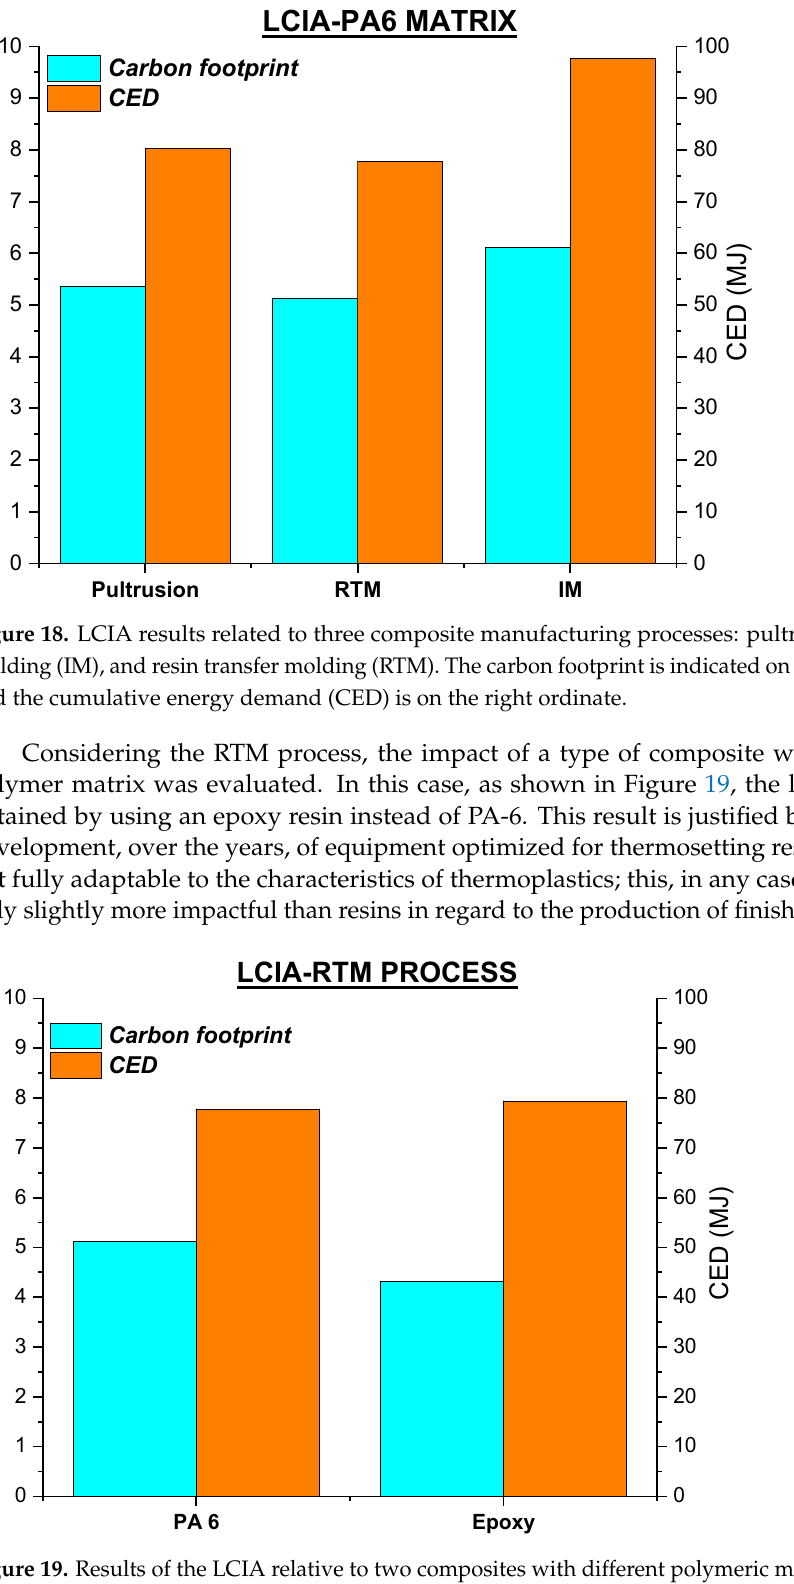
Figure 19. Results of the LCIA relative to two composites with different polymeric matrices: PA6 and epoxy resin. The carbon footprint is indicated on the left ordinate (blue), and the cumulative energy demand (CED) is on the right ordinate